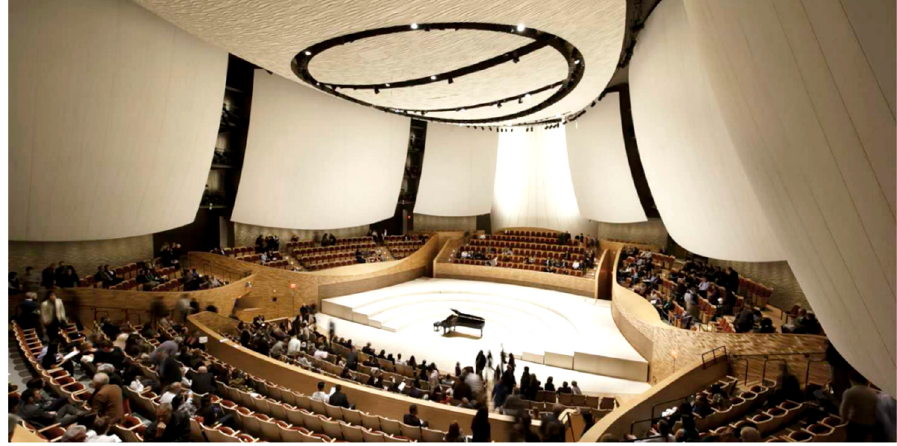
Figure 2. Interior of the Bing Concert Hall in Stanford, CA, USA, completed in 2011.